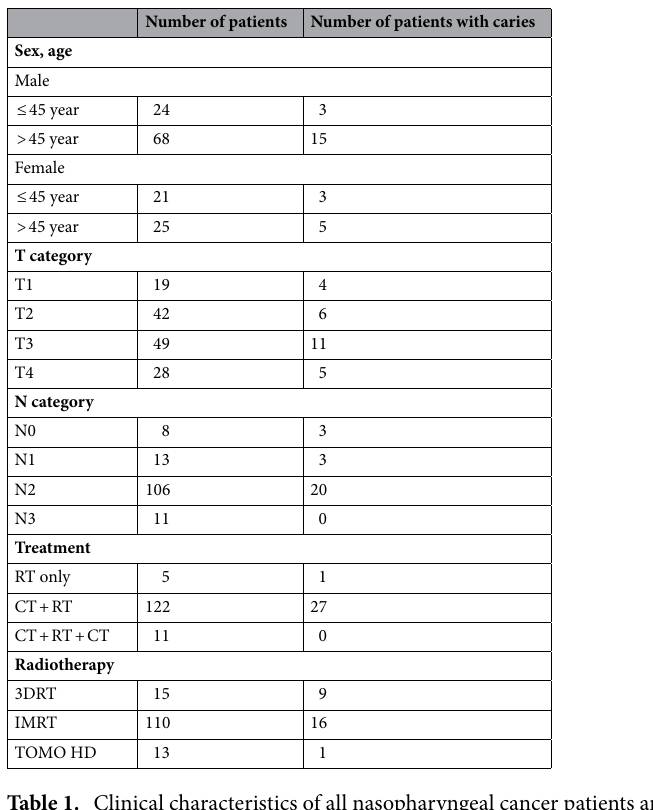
Table 1. Clinical characteristics of all nasopharyngeal cancer patients and patients developing caries. RT Radiotherapy, CT Chemotherapy, 3DRT 3 Dimensional conformal radiation therapy, IMRT Intensity modulated radiation